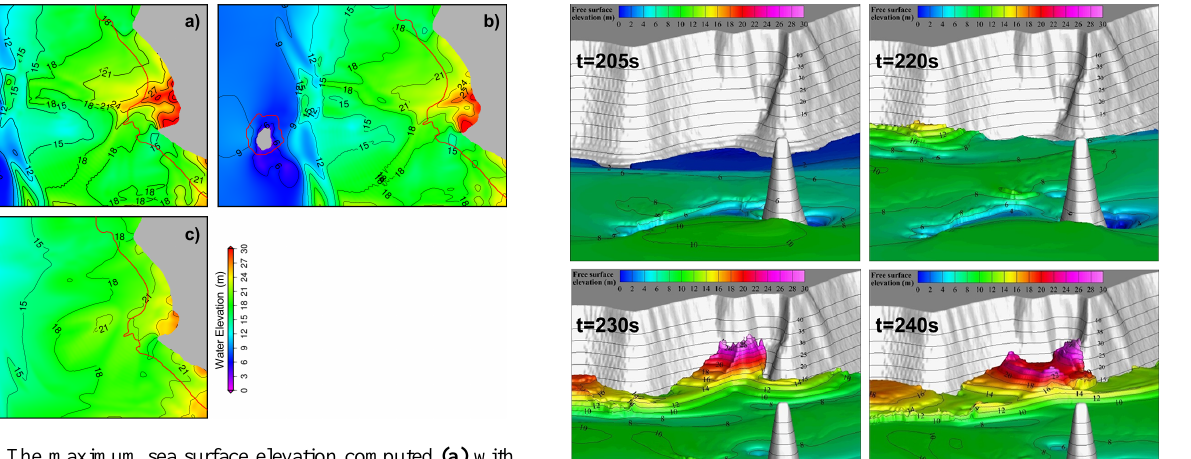
Figure 7. The maximum sea surface elevation computed (a) with two islands, (b) with one island and (c) without islands. Red contour lines indicate original coastlines.